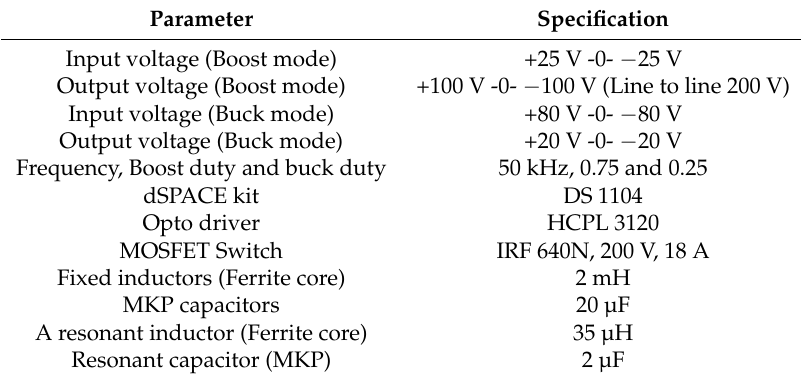
Table 3. Comparison of combustion engine vehicles and electric vehicles.